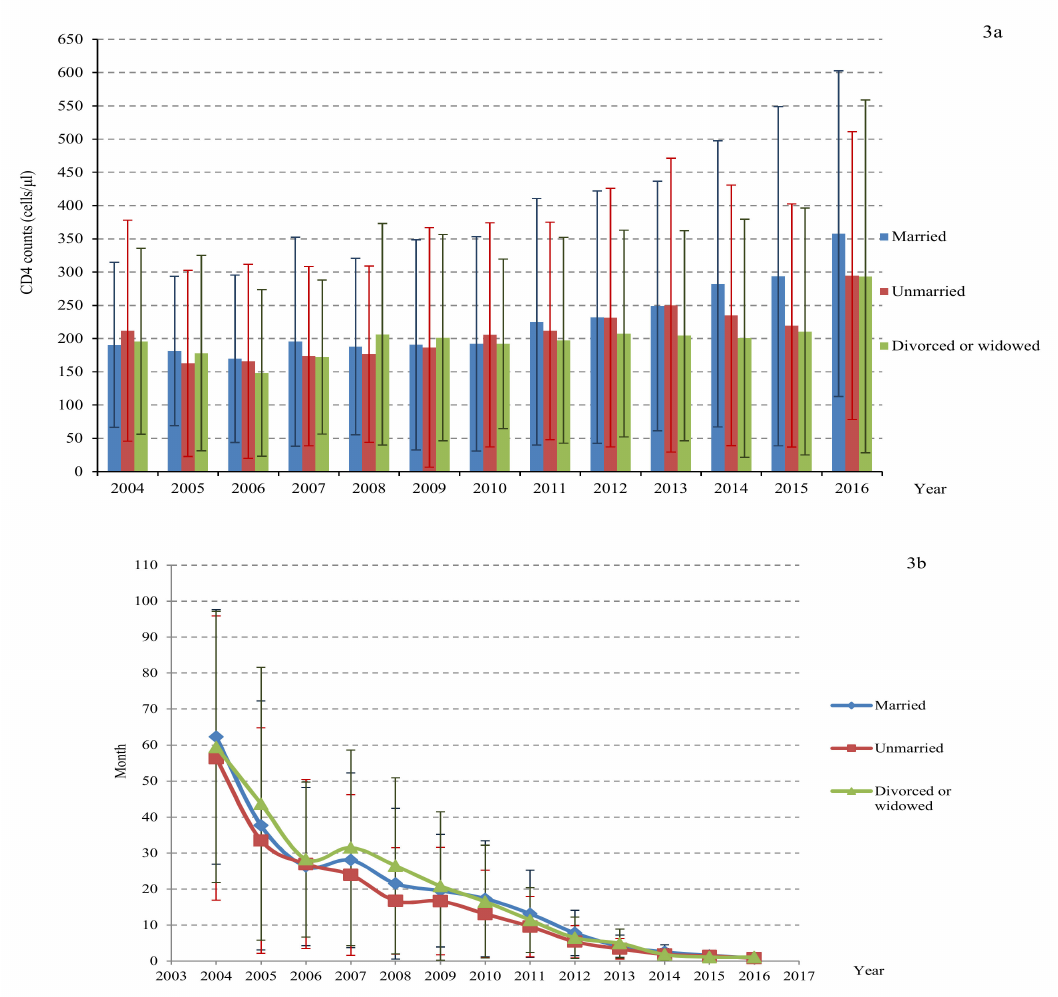
Figure 3. The diagnosed CD4 counts ( a ) and lag time between HIV diagnosis initial ART ( b ) by marital status.